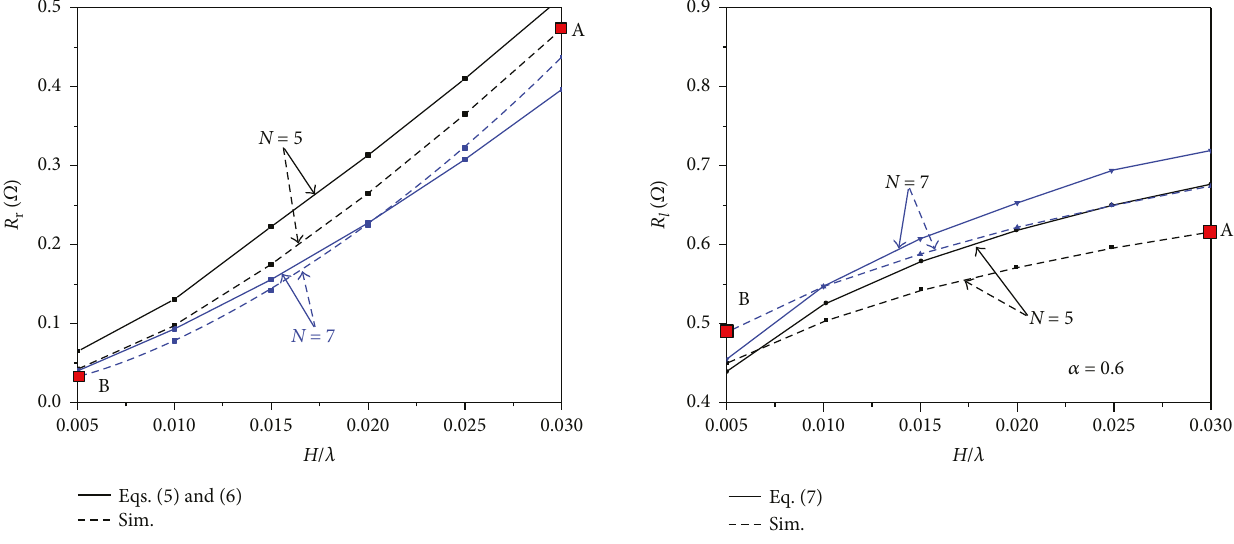
Figure 4: Comparison of NMHA ohmic resistance in free space between the equation results and the simulation results.